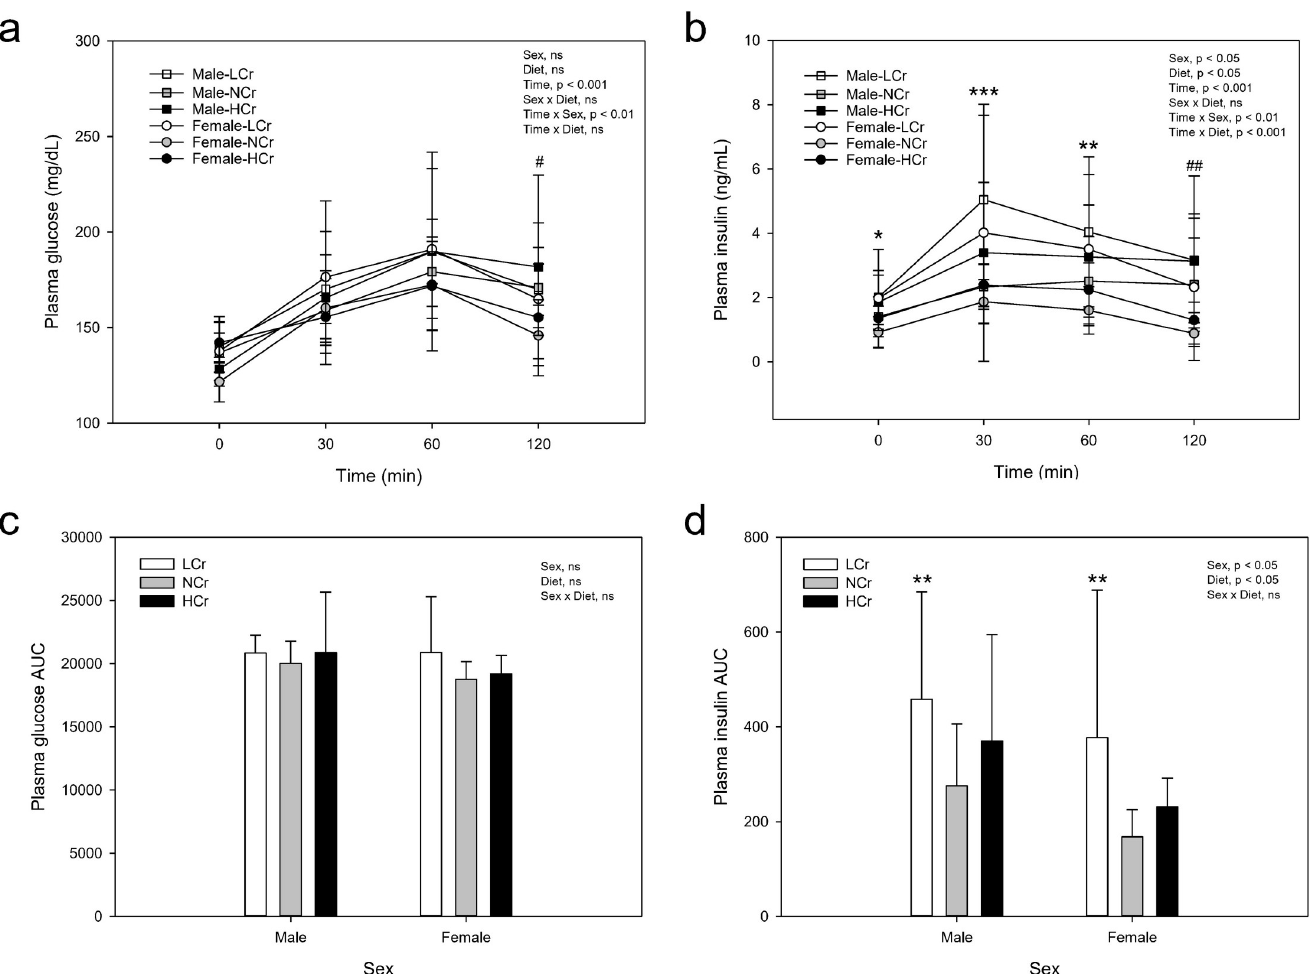
Fig 3. Plasma glucose and insulin responses to an oral glucose challenge conducted at Day 77 of the study. Plasma glucose (a) and insulin (b) concentrations and the respective AUC (c, d). Dextrose solution (0.4 g/mL) was orally administered to the rats (2 g dextrose/kg body weight) by gavage after an overnight fast (12 hour). Blood was collected from the tail vein before dosing (0 min) and 30, 60 and 120 min after dosing. Results are displayed as means ± SD, n = 9 − 10. Results were analyzed by mixed-design ANOVA to determine effects and interactions of time, sex and diet (a, b). For glucose and insulin a significant time × sex interaction (p < 0.01) was observed and univariate results are shown for the effect of sex at each time point ( # , p < 0.05; ## , p < 0.01). For insulin there was a time × diet interaction (p < 0.001). For the effect of diet, results of males and females were pooled and the LCr group differed from the NCr group by Dunnett’s test ( � , p < 0.05; �� , p < 0.01; ��� , p < 0.001). AUC results were analyzed by two-way ANOVA (c, d). For the effect of diet, results of males and females were pooled and the LCr group differed from the NCr group by Dunnett’s test ( �� , p < 0.01). ns, p � 0.05. AUC: Area Under the